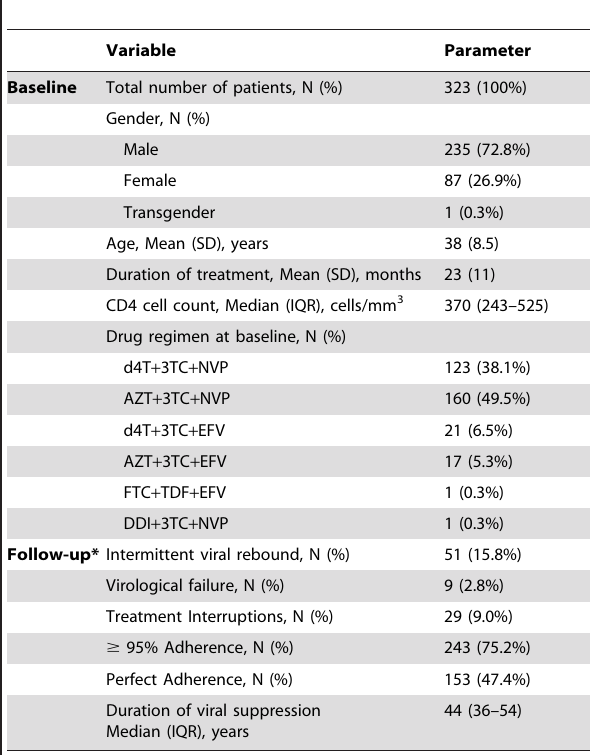
Table 1. Patients’ demographic, clinical and laboratory parameters at baseline and whole study period of 2 years.